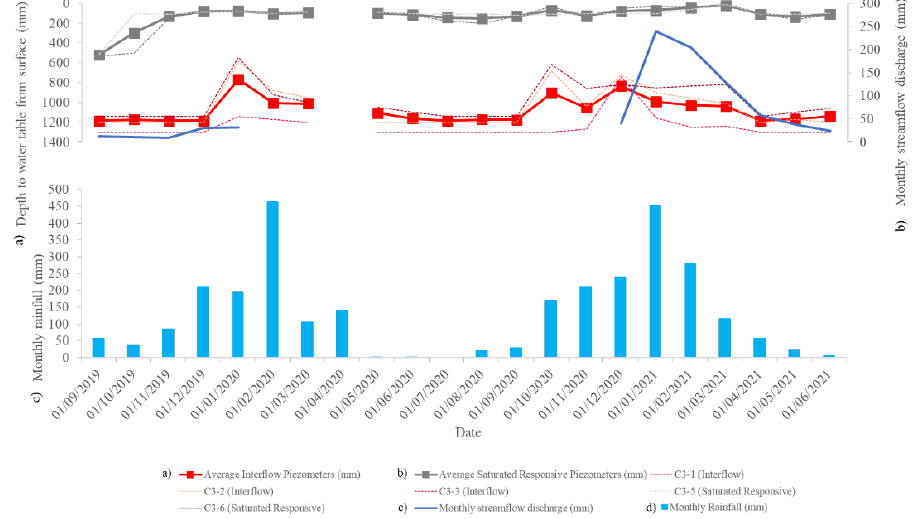
Figure 4. Comparisons of piezometer data installed in the ( a ) interflow soils, ( b ) saturated responsive soils, ( c ) monthly streamflow discharge and ( d ) monthly rainfall CP-III.